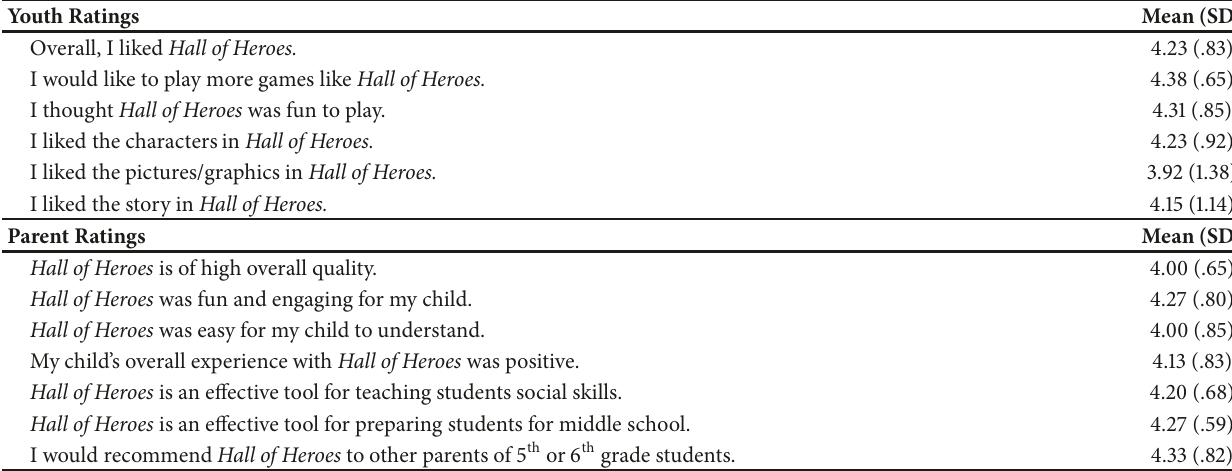
Table 4: Means (SD) of youth and parent evaluations of Hall of Heroes . Youth Ratings Mean (SD) Overall, I liked Hall of